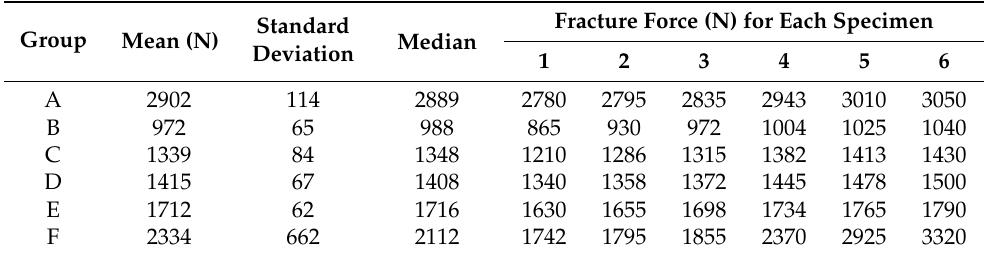
Table 3. The maximum force values at which the teeth in each of the six groups fractured.